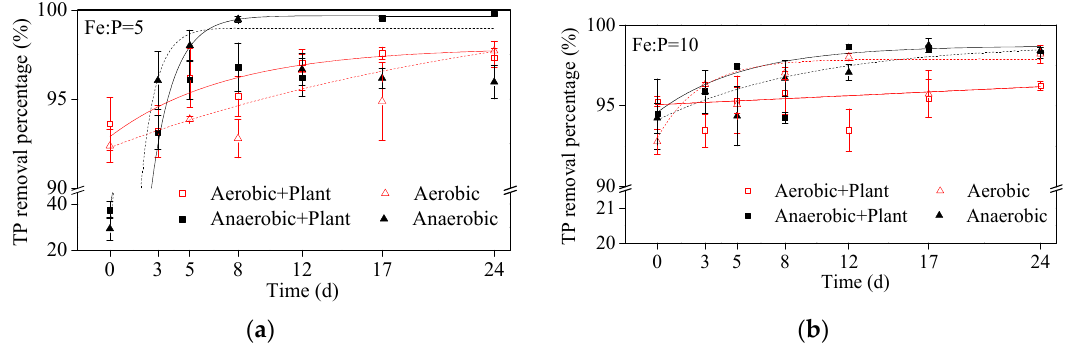
Figure 3. Removal percentage of total phosphorus (TP) in the overlying water. ( a ) Fe:P = 5; ( b ) Fe:P = 10. Table 3. Fitting equations of TP removal when Fe:P = 5.